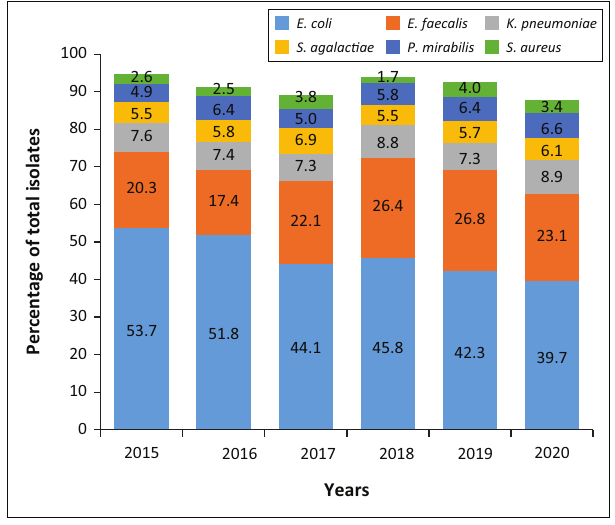
FIGURE 1: Yearly distribution of top six